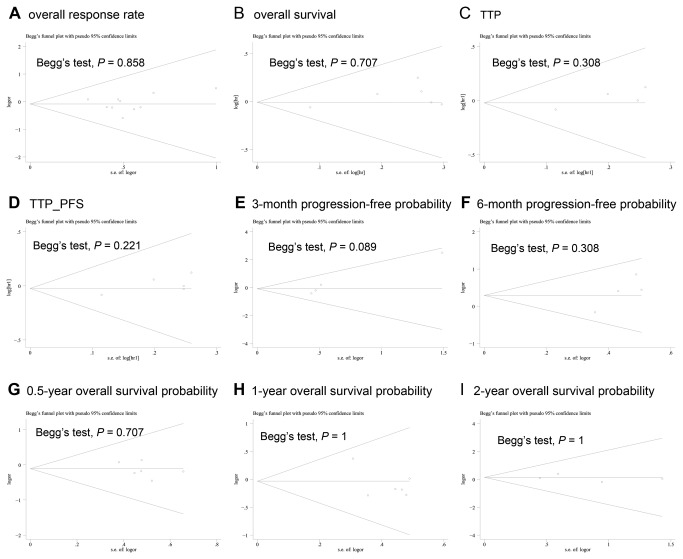
Begg’s funnel plots.